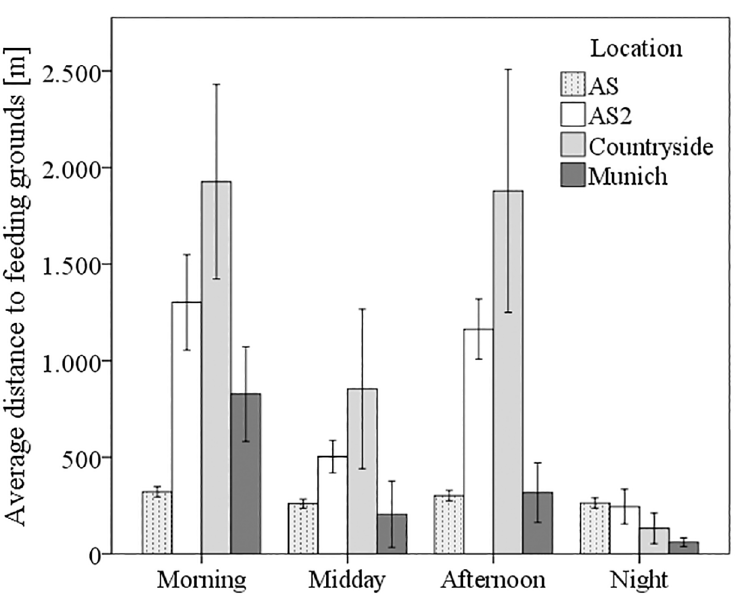
Fig 3. Average distances in meters that greylag geese flew to their foraging sites in the four habitats. (AS1: the Altmuehlsee lake during molt, AS2: the Altmuehlsee lake after molt, Countryside, Munich) during four different periods of the day. (Error bar: 95%